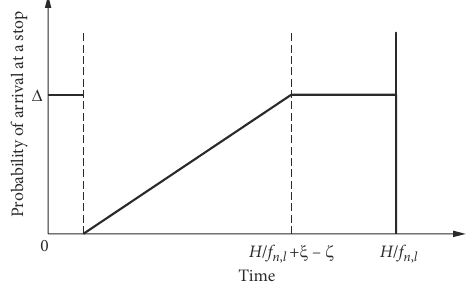
Figure 3. Large allocation interval passenger arrival model A Figure 4. Large allocation interval passenger arrival model B